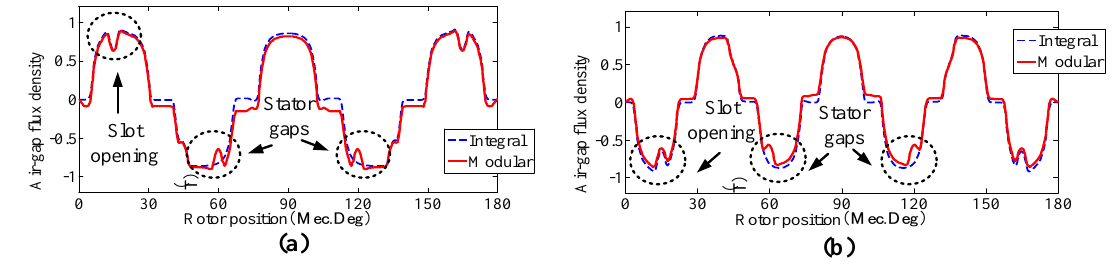
Figure 5. Open-circuit air-gap flux densities. ( a ) 12s / 10p; ( b ) 12s / 14p.